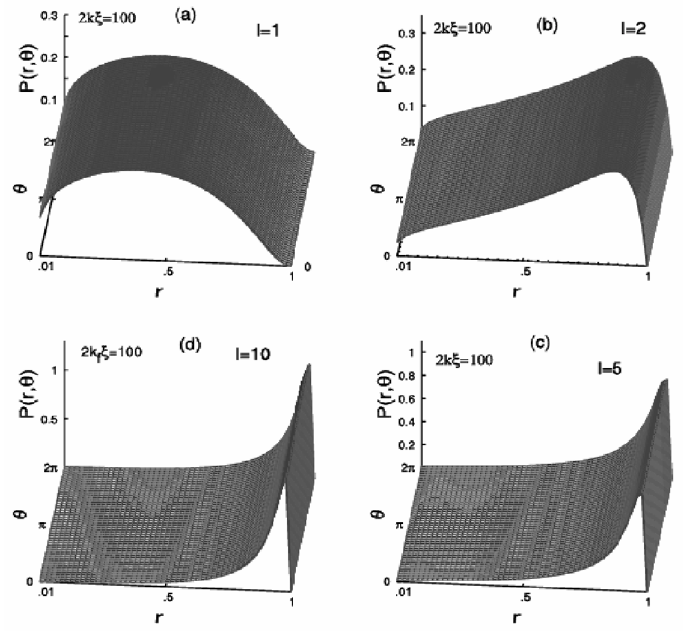
Figure 2. Evolution of the probability P ( r , θ ) with the sample length l (= L / ξ ) in the weak disorder regime for a fixed disorder strength parameter 2 k ξ = 100. Plots are for sample lengths: ( a ) l = 1, ( b ) l = 2, ( c ) l = 5, and ( d ) l = 10.